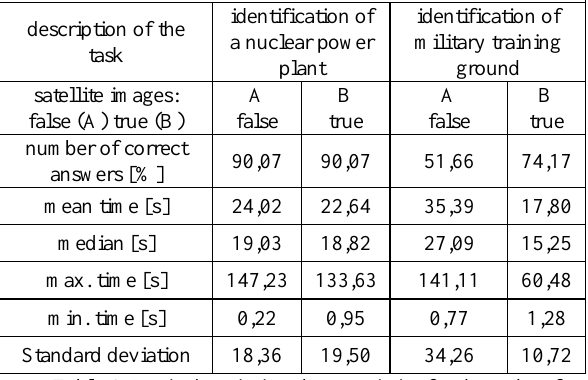
Table 6. Basic descriptive characteristics for the tasks